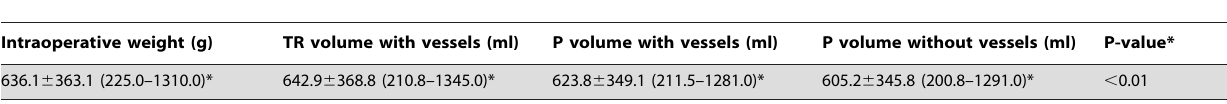
Intraoperative weight (g)